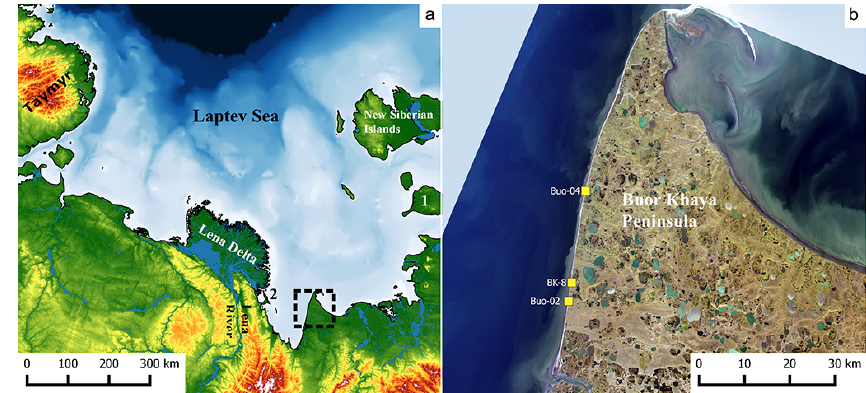
Figure 1. Study area in the central Laptev Sea region ( a ; based on IBCAO 3.0 Jakobsson et al., 2012) including Buor Khaya Peninsula marked by the black frame and Yedoma IC reference sites on Bol’shoy Lyakhovsky Island (1) and Bykovsky Peninsula (2); position of the study sites Buo-02, Buo-04, and BK-8 at the western coast of the Buor Khaya Peninsula ( b ; LANDSAT_8 image from